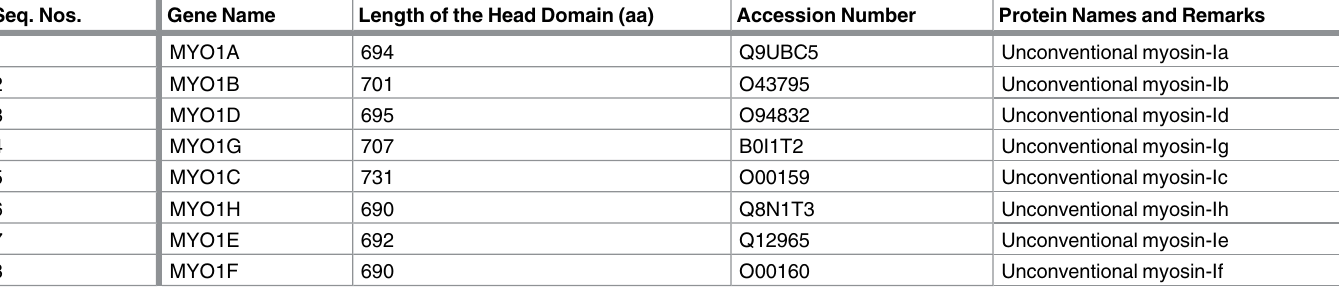
Table 4. Details of unconventional myosin sub-family MYOI class membersin human. Seq. Nos.